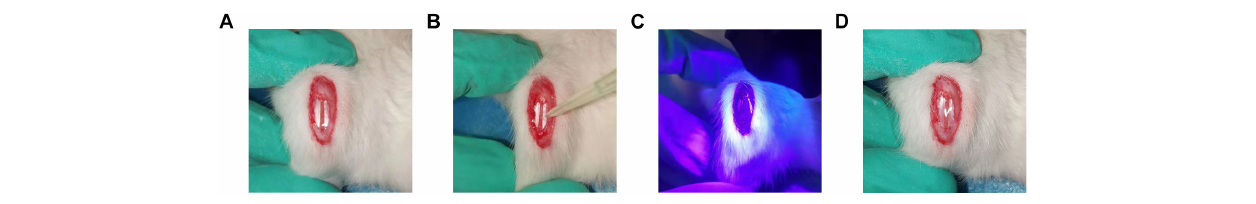
FIGURE 1 | Establishment of patellar tendon injury model. (A) The central third of the patellar tendon was removed, resulting in a tendon defect. (B) GelMA containing stem cells was infused into the Patellar tendon defect. (C) Radiation with a 405-nm light source for 10–20 s at a distance of 3 cm from the tendon defect. (D) Cross-linking to form the gel